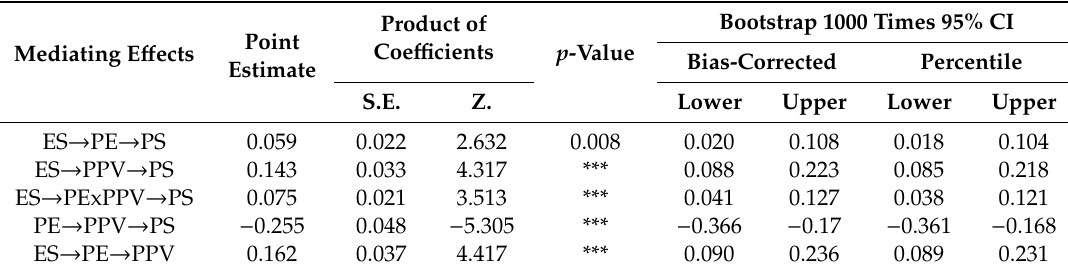
Table 6. Bootstrapping analysis for indirect e ff